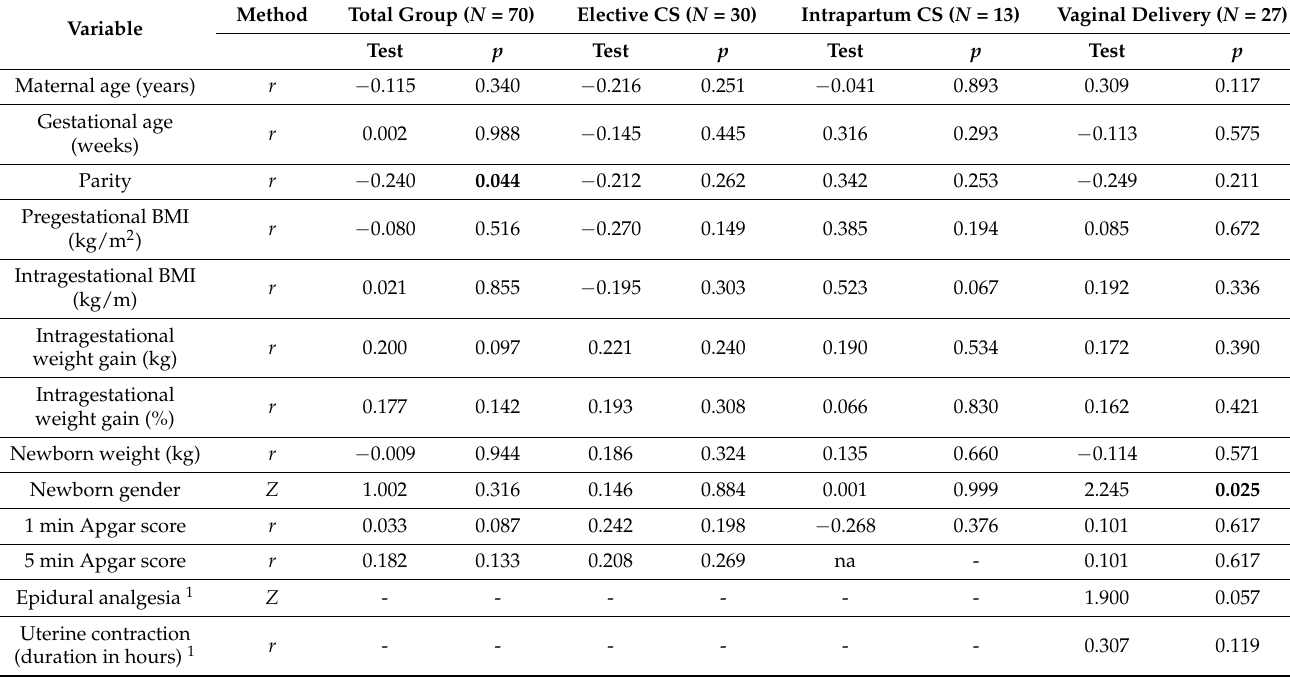
Table 4. Correlations between ADIPOQ demethylation index and maternal or neonatal